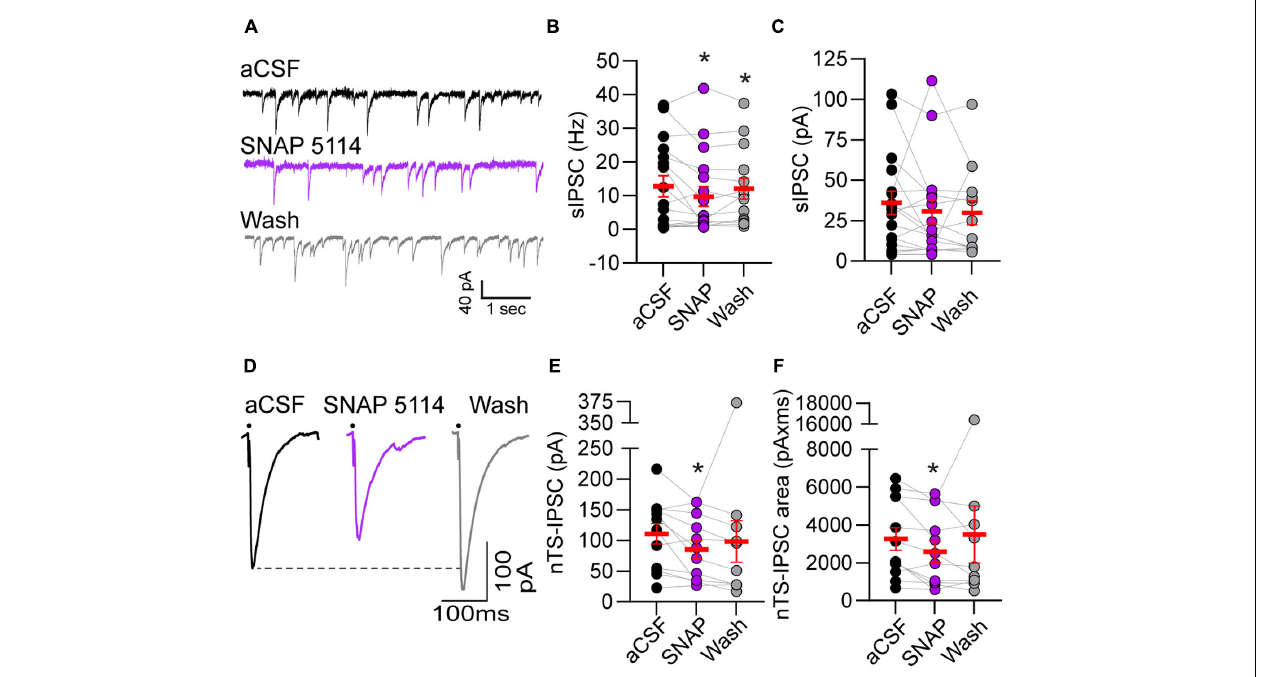
FIGURE 3 | Gamma-aminobutyric acid transporter 3 blockade reduced spontaneous and evoked IPSCs. (A) Representative example of spontaneous IPSCs under baseline aCSF, in the presence of GAT-3 antagonist SNAP 5114 and in aCSF wash. All recordings were done in the presence of the AMPA and NMDA receptor blockers NBQX and AP5, respectively, in the aCSF and a high chloride intracellular solution to produce inward GABAergic currents. Note the reduction in frequency with GAT-3 blockade. Quantitatively, sIPSC frequency was decreased (B) but amplitude was unchanged (C) suggesting pre-synaptic reduction in GABA release. n = 17. Mixed-effects analysis with LSD post hoc : (B) F (2,29) = 3.619; (C) F (2,29) = 0.4792, * p ≤ 0.05 vs aCSF. (D) Representative trace of nTS-IPSCs evoked at 0.5 Hz. Dots denotes time of nTS-stimulation (artifacts removed for clarity). GAT-3 block decreased nTS-IPSC amplitude and area compared to aCSF baseline, which is quantified in (E,F) ( n = 12). Mixed-effects analysis with Geisser–Greenhouse correction and LSD post hoc : (E) F (1.331,13.31) = 1.130, ε = 0.6654; (F) F (1.064,10.64) = 0.5885, ε = 0.5319, * p ≤ 0.05 vs aCSF. Data in (B,C,E,F) are shown as individual neurons (connected circles), their responses, and means ± SEM in red.